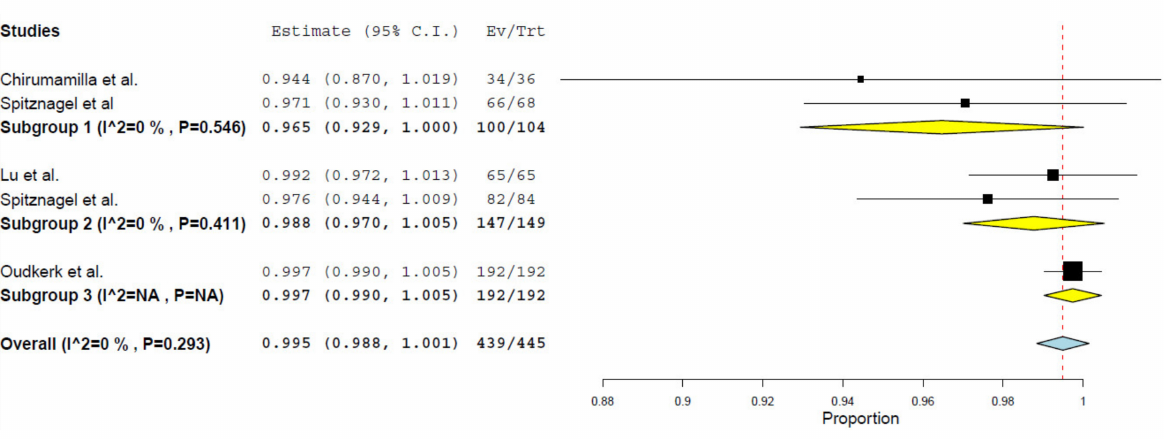
Figure 3. Two-year survival forest plot for PICN.